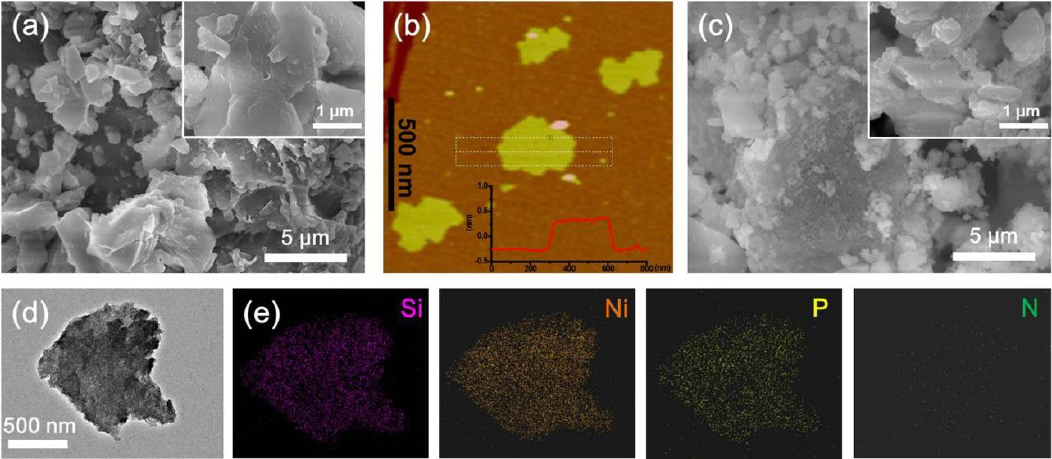
Figure 1. ( a ) SEM images of serpentine, ( b ) AFM image of serpentine (Insert is the height of the selected curve); ( c ) SEM image, ( d ) TEM image, and ( e ) the corresponding EDX elemental mapping of Si, Ni, N, and P elements of serpentine@APP.